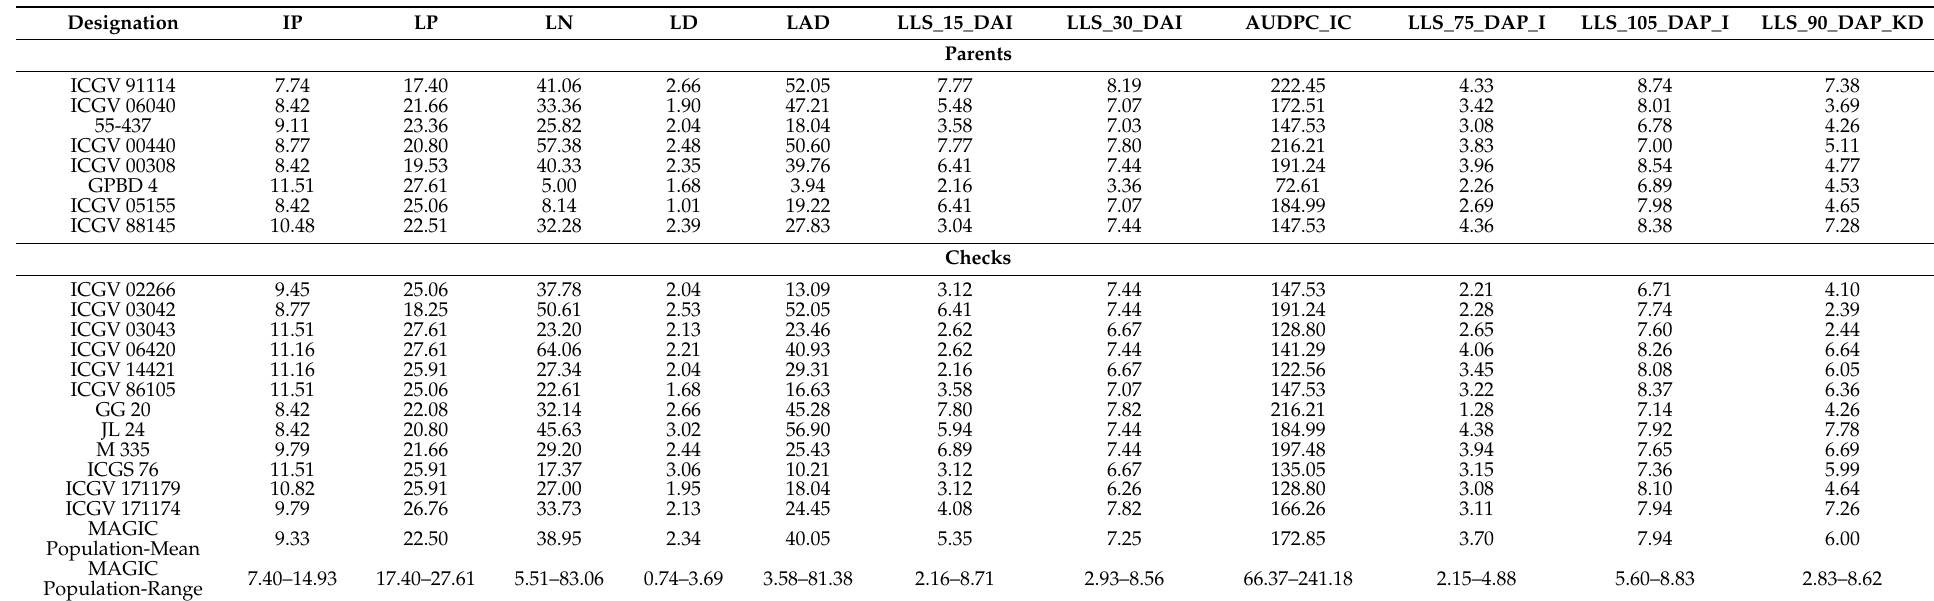
Table 4. Mean values of parents, checks and MAGIC population for different traits used in this